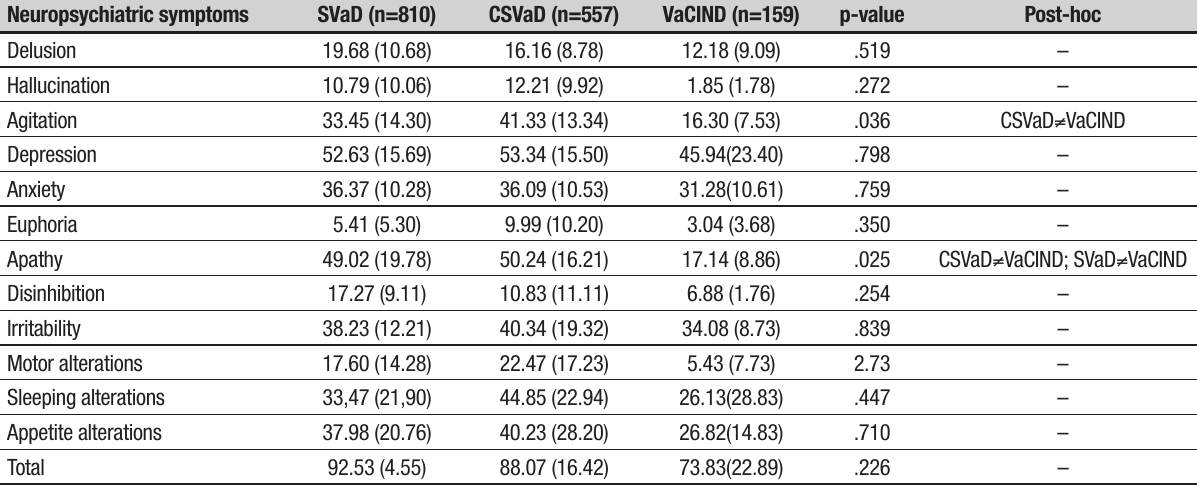
Table 3. Comparison of mean Neuropsychiatric Symptom prevalences among SVaD, CSVaD and VaCIND groups. Neuropsychiatric